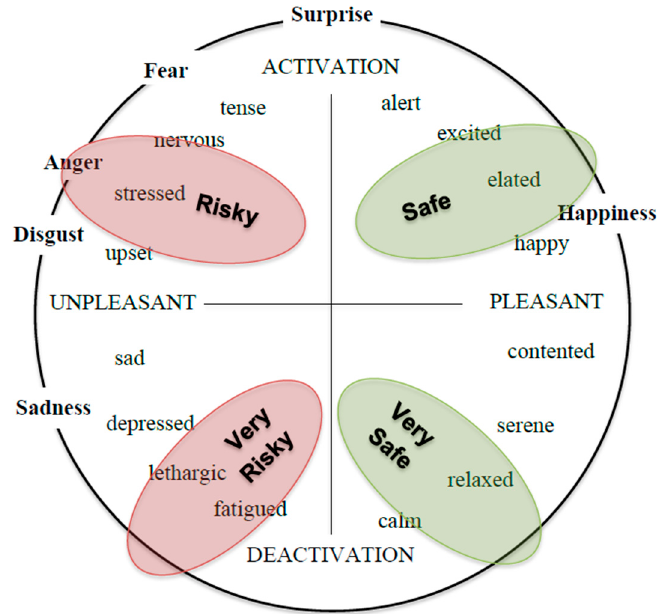
Figure 2. The affective circumplex with adaptation of an overlay of four colored ovals, representing which quadrants likely relate to safer or riskier driving behaviors. Adapted from [23]. Representative studies to support the effect on driver behavior are covered in Section 2 and Table 1.